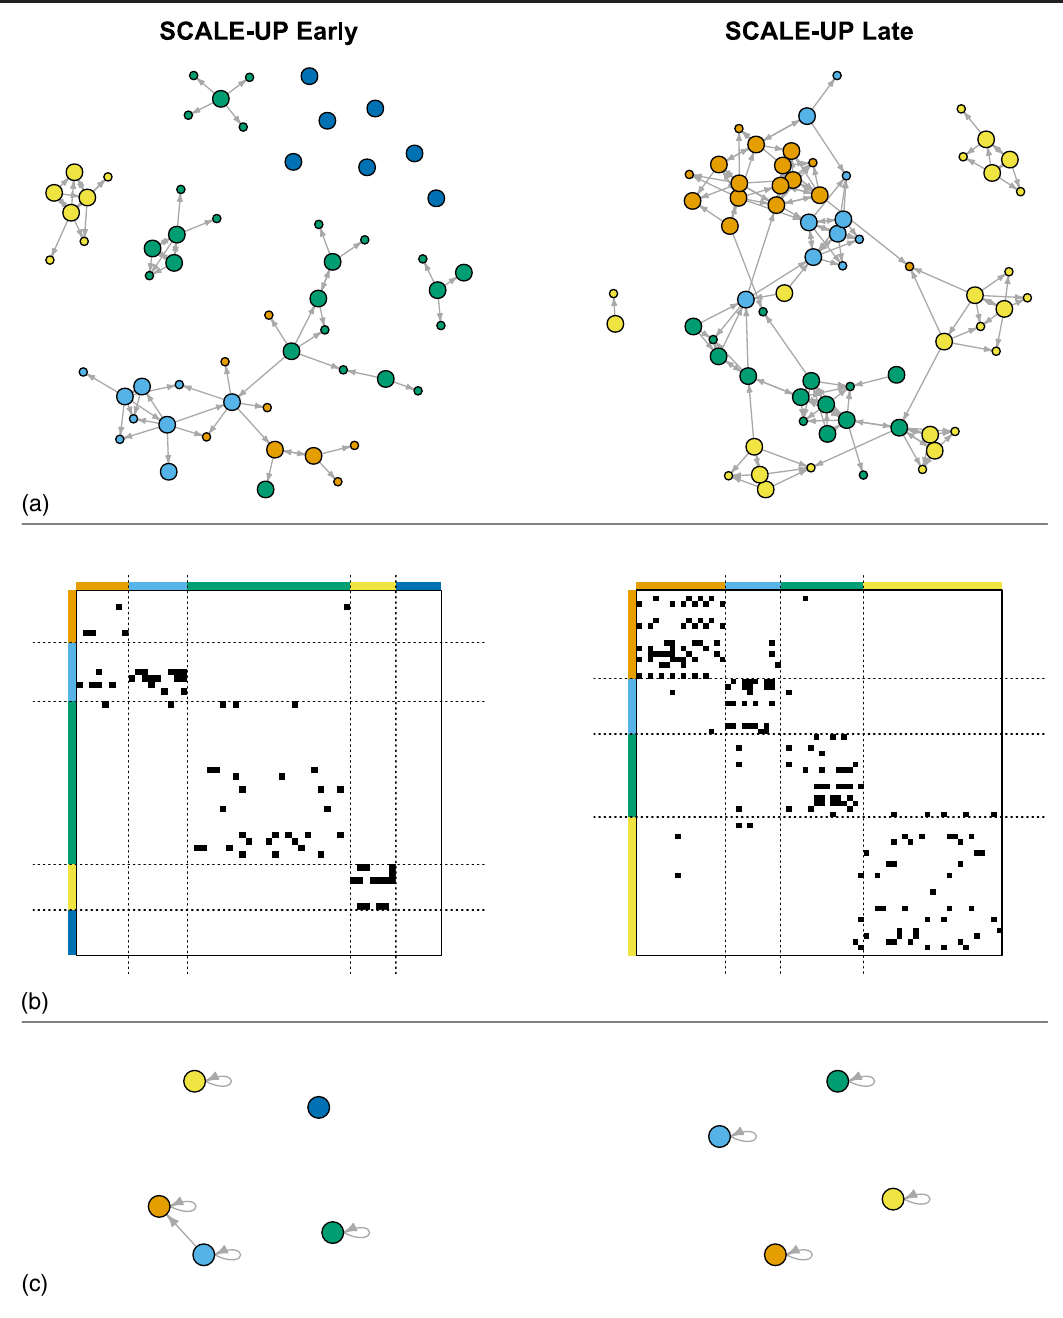
FIG. 4. (a) Network diagrams, (b) blockmodels, and (c) reduced network diagrams for SCALE-UP section. Smaller circles on the network diagrams are students who did not take the survey but were named by respondents. Nodes are colored by CONCOR partition, and dotted lines on the blockmodel plots show the same